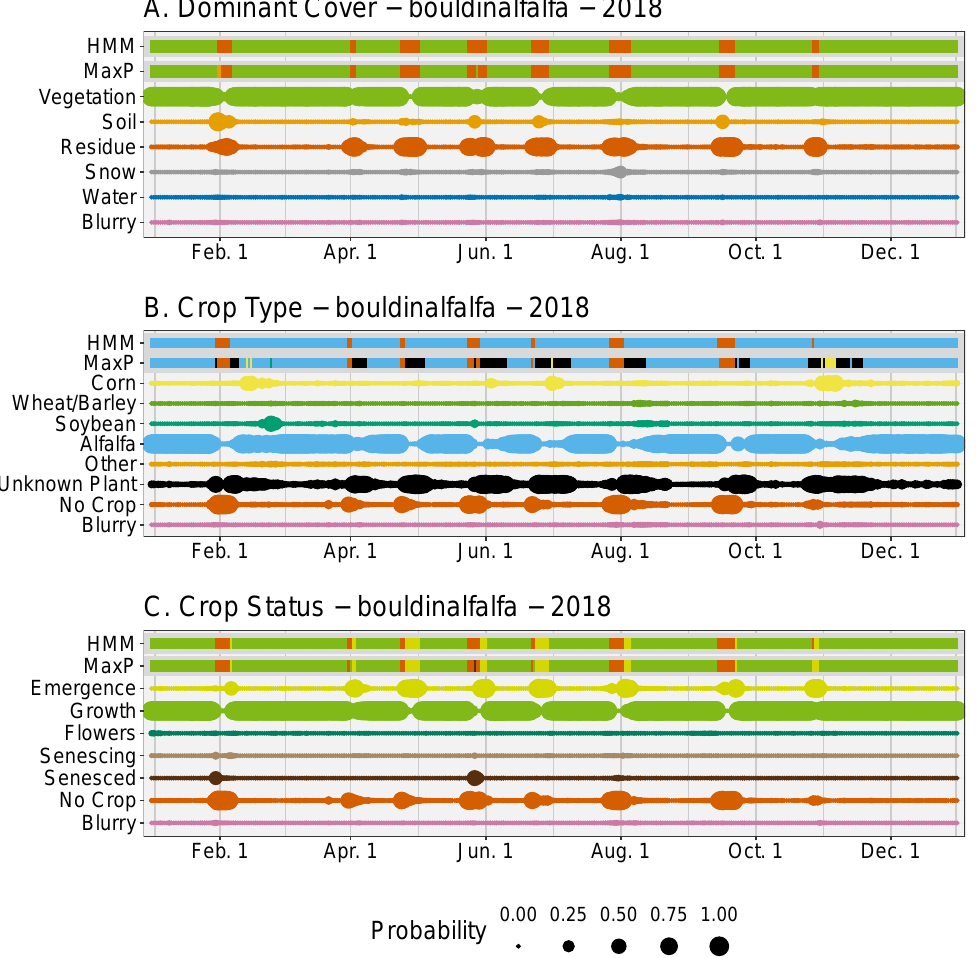
Figure 5. Classification results for the bouldinalfalfa site for the year 2018. The panels represent the results for the Dominant Cover ( A ), Crop Type ( B ), and Crop Status ( C ) categories. The top two rows of each panel represent the final classification for either the daily maximum probability (MaxP) or the hidden Markov model (HMM). The remaining rows in each panel represent the initial model classification for the respective class, where larger sizes represent higher